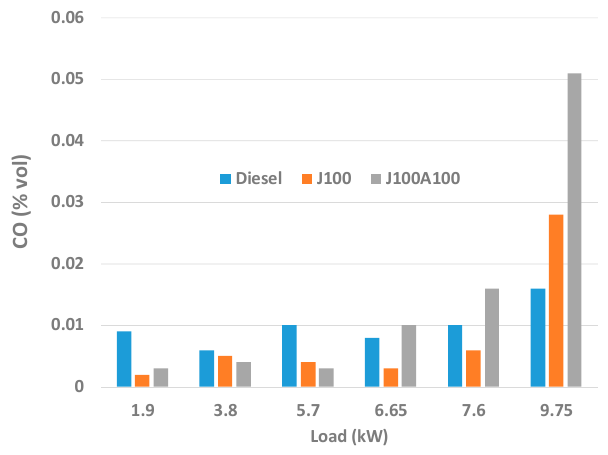
Figure 5. Brake thermal efficiency (BTE) vs. engine load.